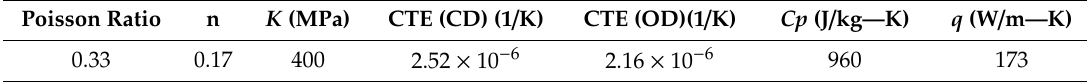
Figure 3. Optical micrographs for an SO sample; ( a ) after forging at low temperature, ( b ) after solution at 475 °C for 45 min, and (c) after solution at 475 °C for 90 min.